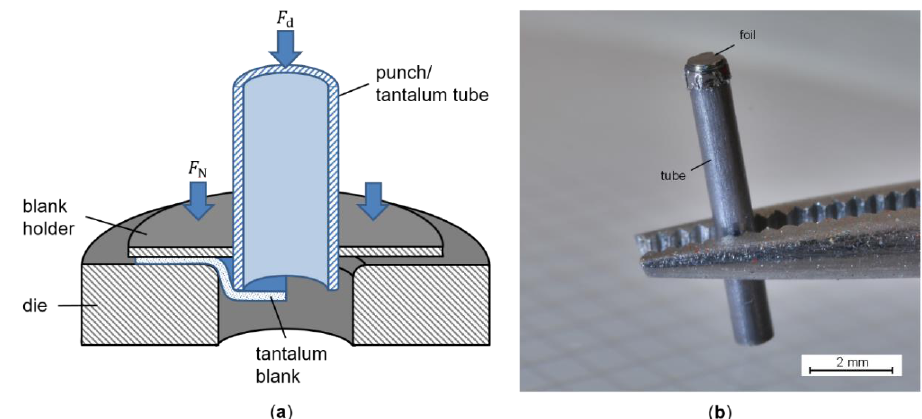
Figure 2. Preparation of the refractory tantalum probes: ( a ) deep-drawing process of the tantalum foil, and ( b ) a finished, ready-to-use probe.